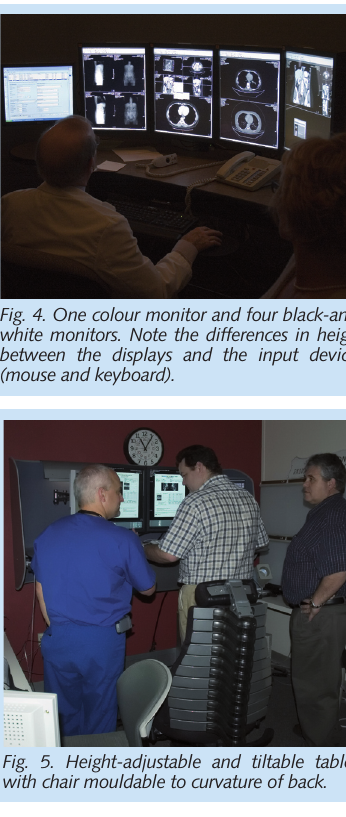
Fig. 3. One colour monitor and one wide colour monitor.